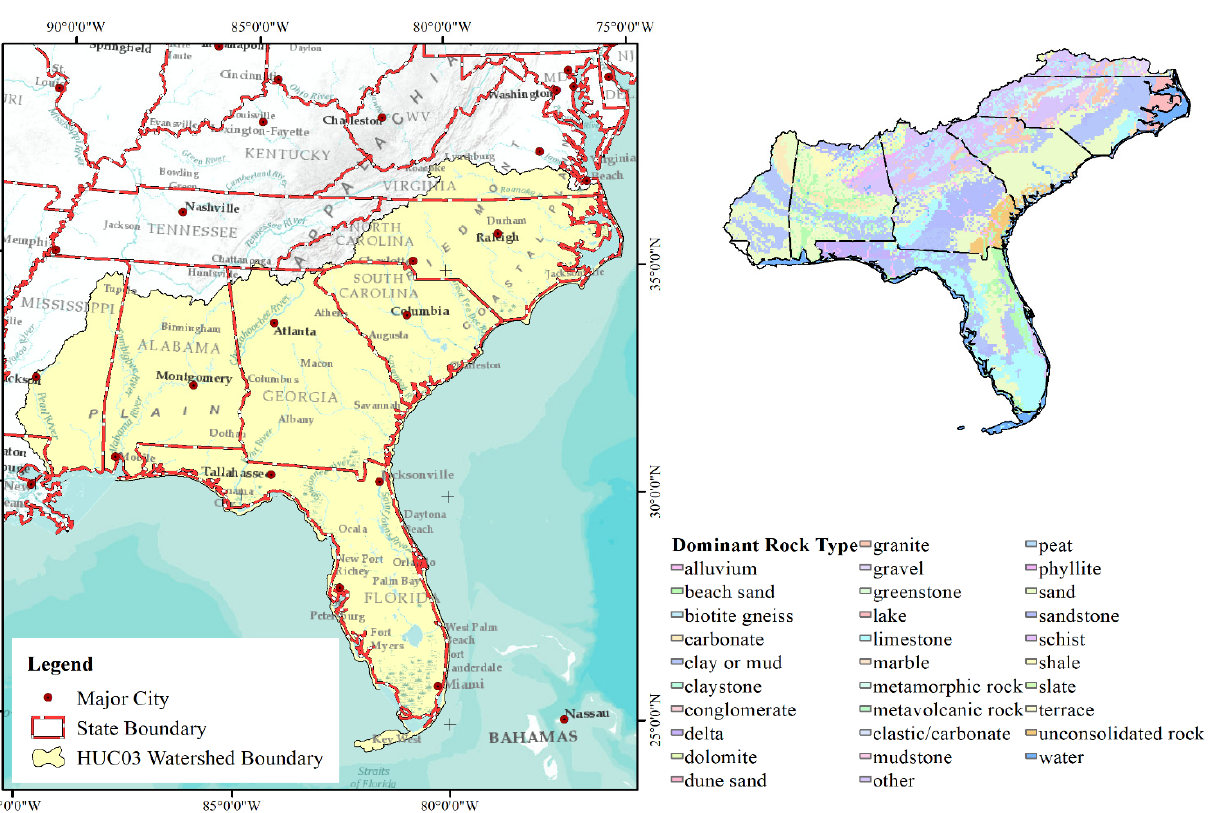
Figure 1. Location of main cities in HUC-03 watershed boundary and dominant rock-type. The majority of the study region lies in the Floridian aquifer system (FAS). It spans Southeast Alabama, Georgia, South Carolina, and Florida. It is divided into upper and lower FAS and consists of limestone and dolomite. FAS consist of four major